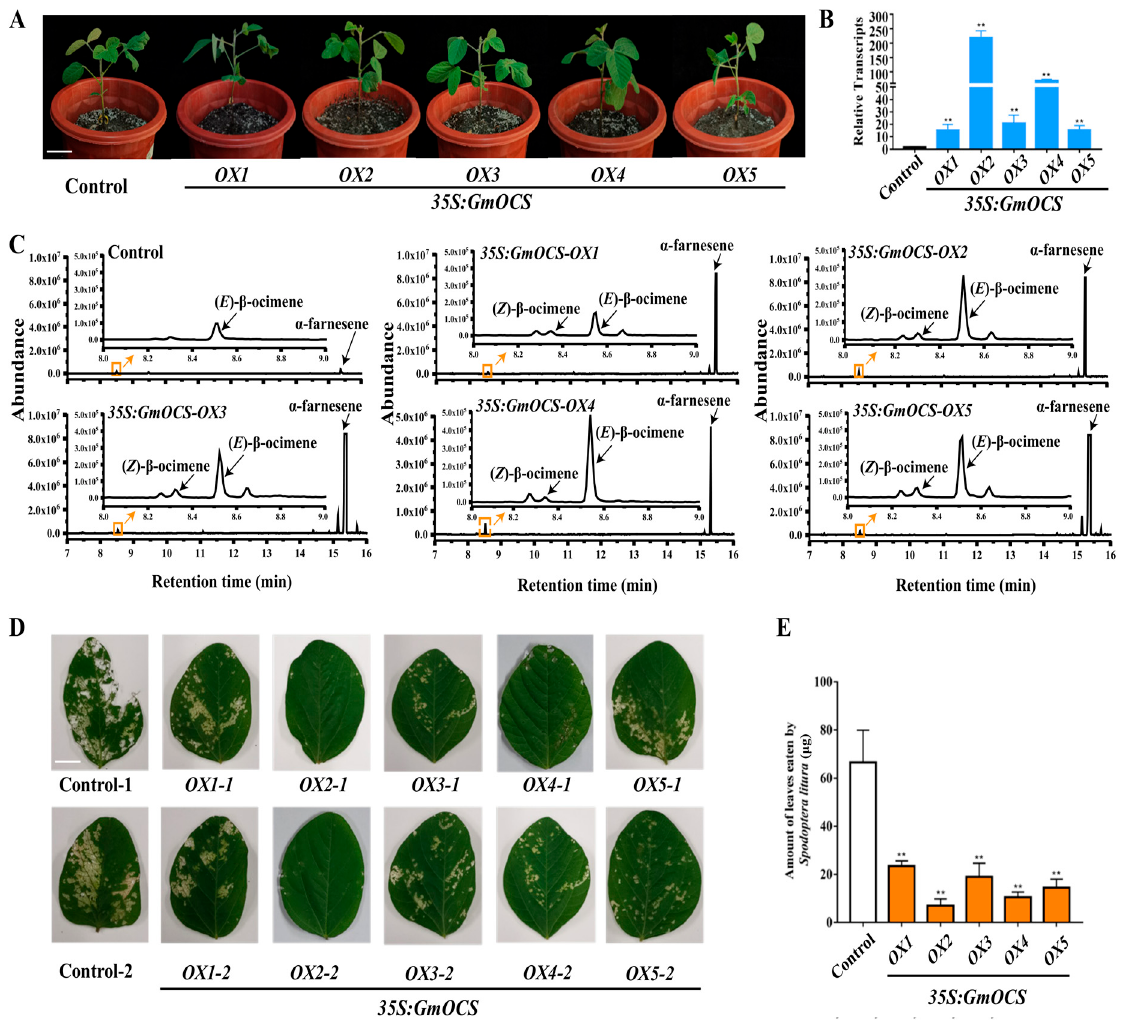
Figure 5. The overexpression of GmOCS in soybean plants led to enhanced resistance against S. litura . ( A ) Control and transgenic soybean plants overexpressing GmOCS . ( B ) The relative expres- sion levels of GmOCS in transgenic soybean leaves compared with the control. ( C ) Volatile terpenes detected in the control and transgenic soybean leaves overexpressing GmOCS . ( D ) S. litura attacked wild leaves and transgenic leaves, overexpressing GmOCS in a dual-choice feeding-preference ex- periment. ( E ) Leaves of wild and GmOCS overexpressed lines eaten by S. litura in dual-choice feeding-preference experiment. Data represented the mean ± SD of three biological replicates, and the student’s t -test was used to analyze the significance of differences (** p < 0.01) in ( B , E